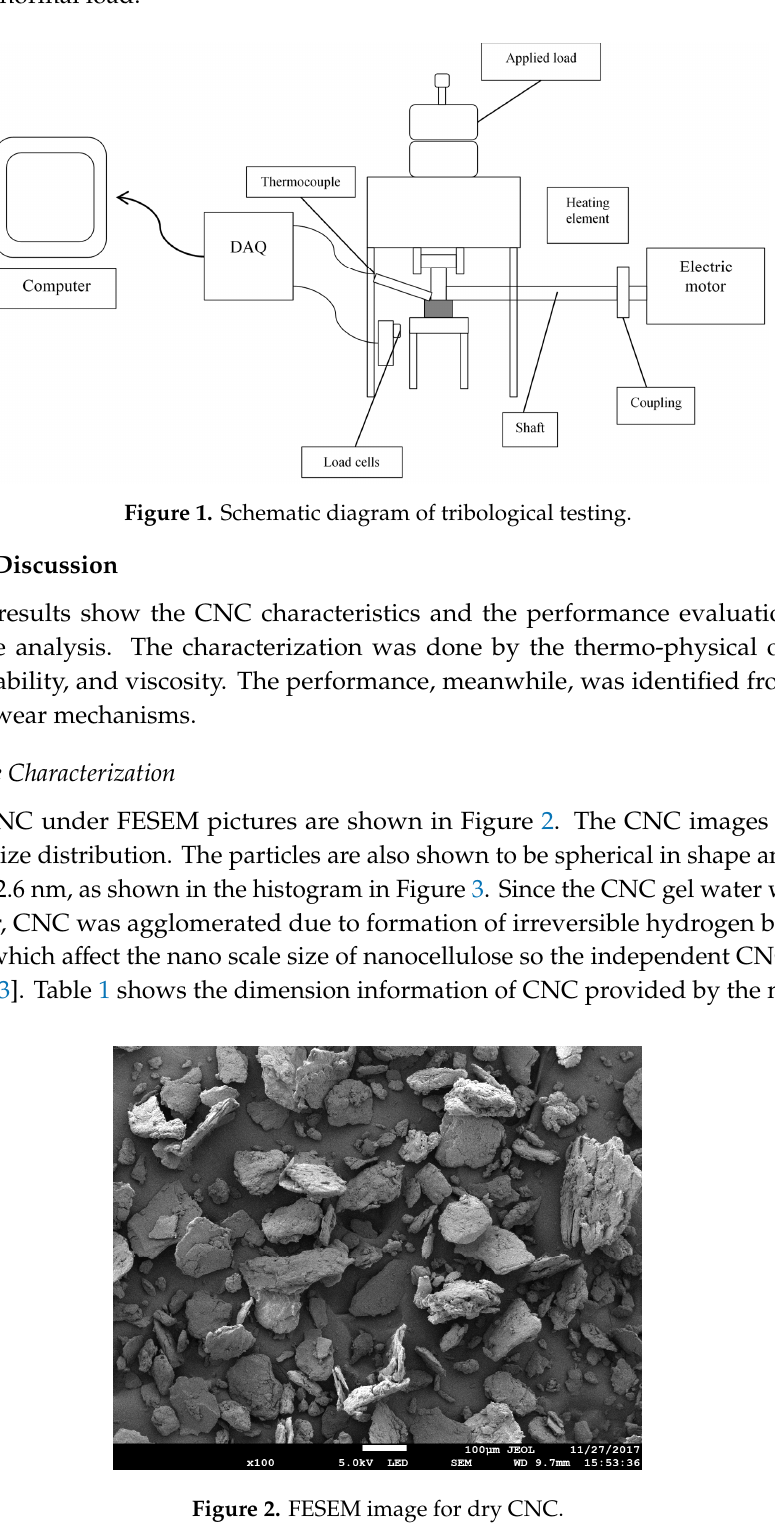
Figure 2. FESEM image for dry CNC.